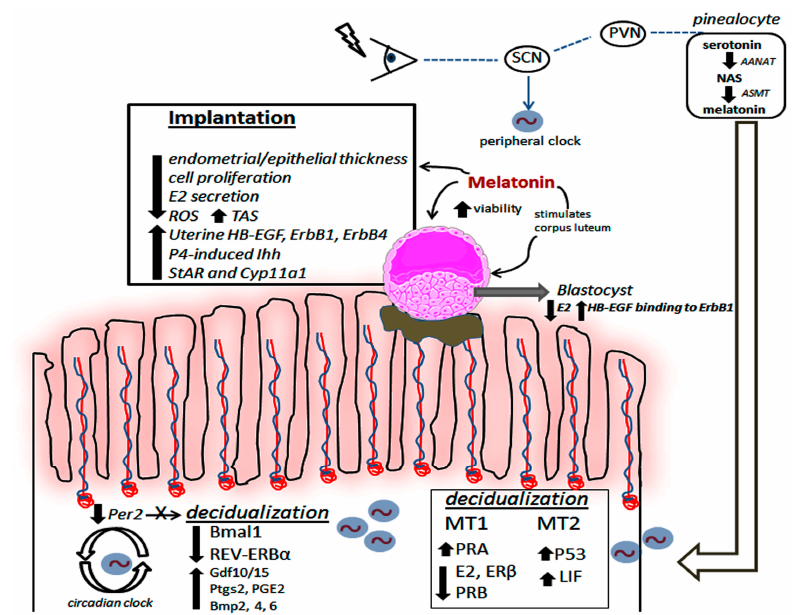
Figure 1. Cyclic production of melatonin, from external (e.g., pineal and possibly extrapineal sources) or internal uterine sources, is responsible for promoting decidualization and improving implantation. Circadian disruption of Per2 affects decidualization and a significant reduction in Bmal1 and REV- ERB α may favor the process via different molecular signaling pathways. Melatonin seems to reduce E2 while increasing the levels of decidualizing-related molecules, i.e., P53 and LIF, in the uterine tissue. In the blastocyst, melatonin directly induces higher viability (by reducing E2 and enhancing HB-EGF-ErbB1 pathway) and also indirectly by stimulating corpus luteum activity. To improve implantation, melatonin modifies the endometrial and epithelial thickness by lowering E2 levels while increasing its glandular density; these, in turn, result in ROS attenuation with high production